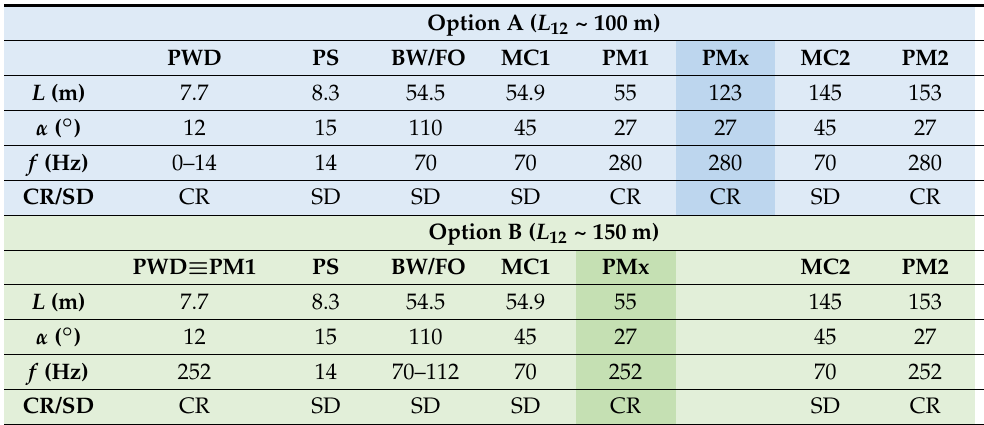
Figure 5. Calculated wavelength spectrum, TOF distribution zoomed for one elastic bandwidth of about 2.5 ms and a sketch illustrating only the pulse multiplication (PM) chopper cascade for Option A. ( a ) using two fast choppers and ( b ) after introducing a third fast chopper at L PMx ~104 m. Table 2. Main parameters (location, L , slit size, a, frequency, f , and whether the chopper is counter ro- tating double disk (CR) or single disk (SD)) for the proposed chopper layouts for pulse multiplication in MIRACLES, using three fast